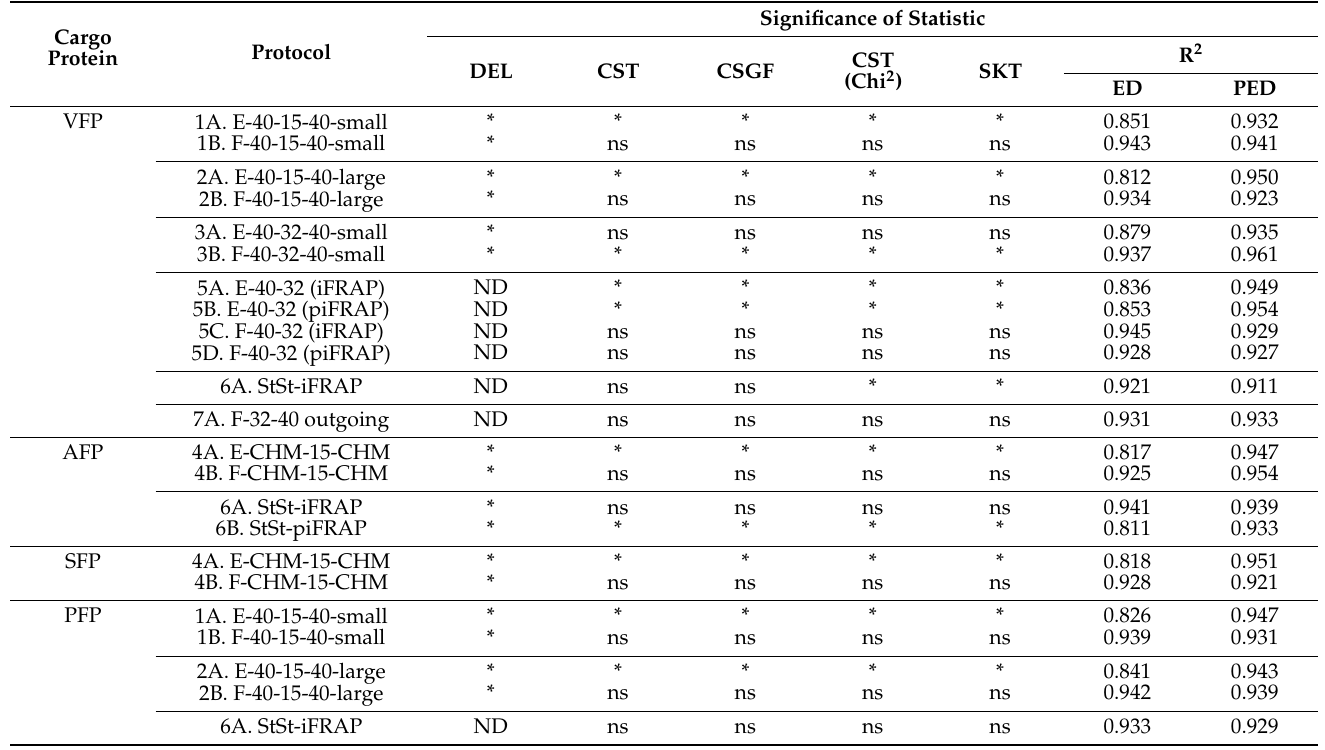
Table 3. Evaluation of empirical curves for the goodness-of-fit of the theoretical curves to exponential decay (see also Figure S1XIX).